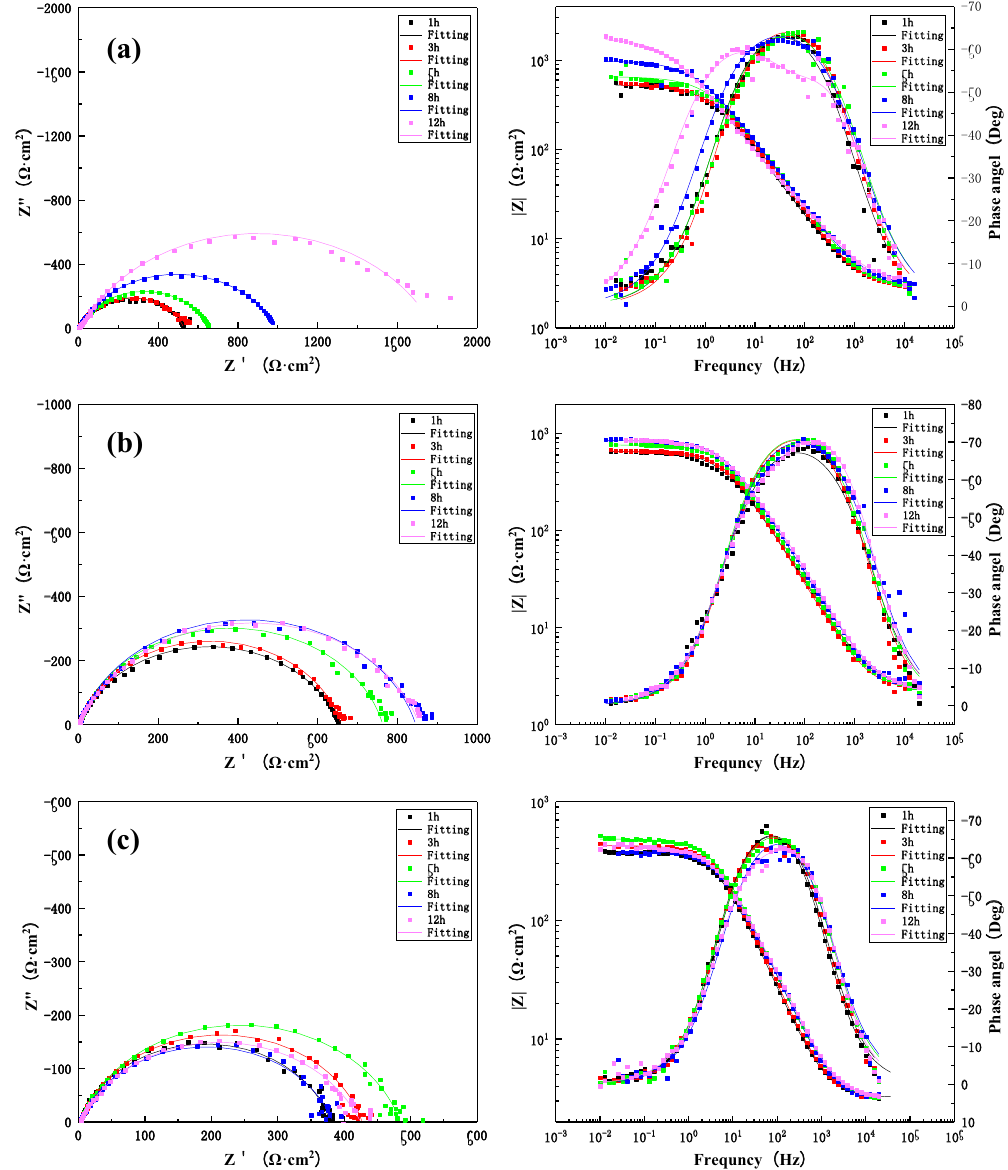
Figure 7. The change in impedance of the BM after 12 h scouring in seawater with three different flow rates: ( a ) 1.85 m/s, ( b ) 3 m/s, ( c ) 6